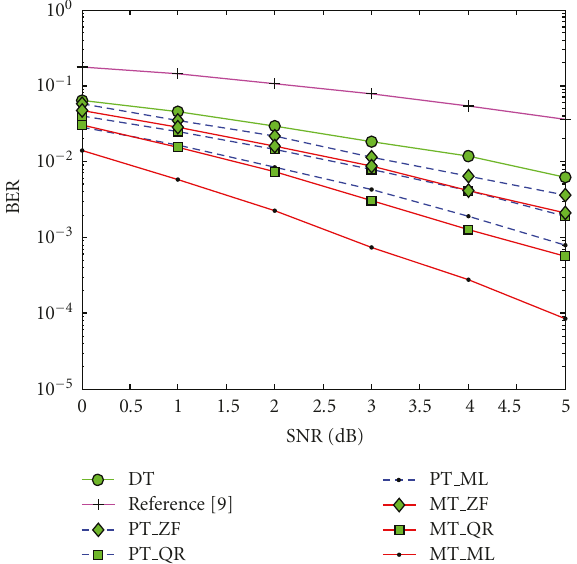
Figure 7: BER versus SNR (SNR in = SNR + 10 dB, SNR rd = SNR + 5